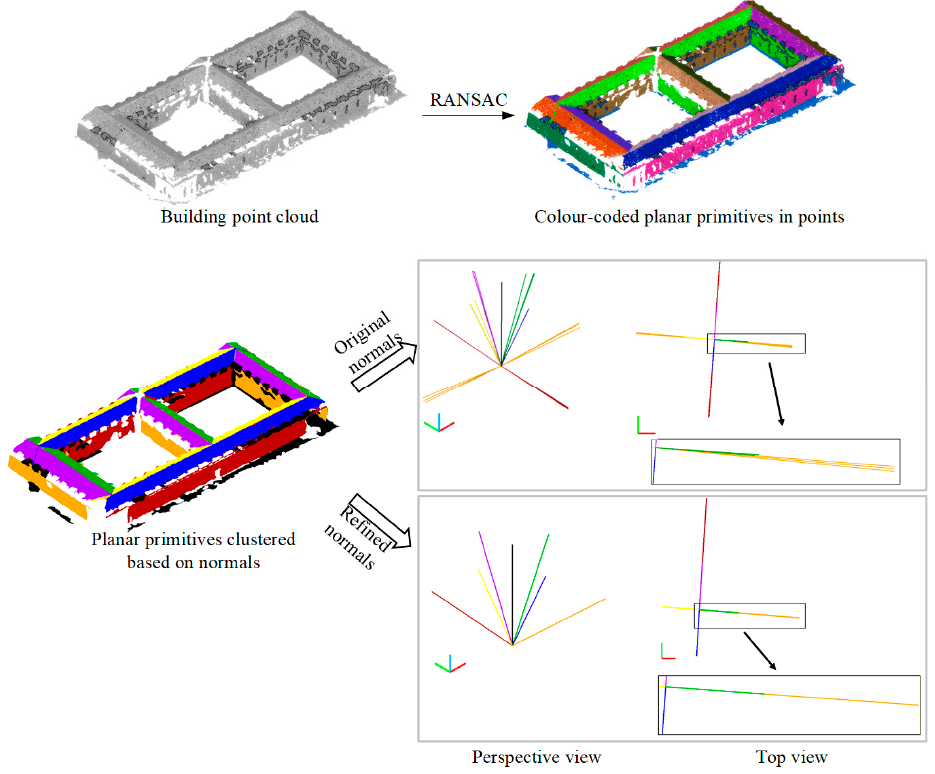
Figure 2. Planar primitives extracted from the point cloud and refinement of normal vectors of the planes.